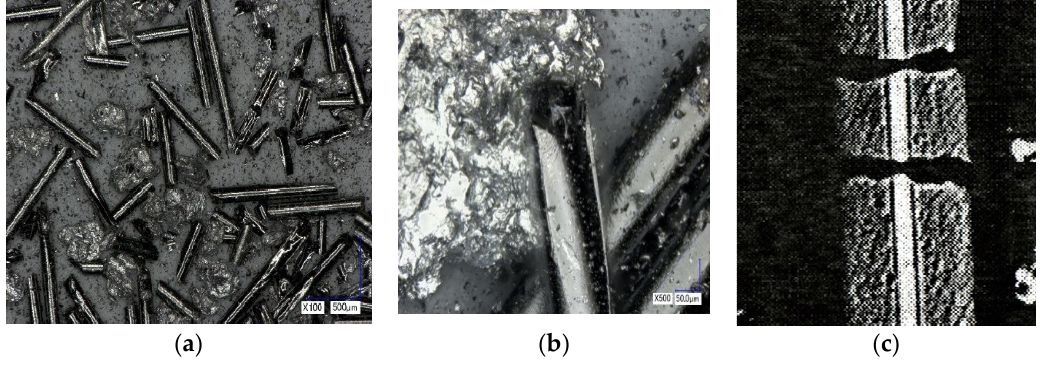
Figure 5. Microstructure of Al-W-B composite after grinding in a vibrating mill ( a – c ). The grinding in the disintegrator makes it possible to obtain a fraction of the powder component in a given range (Figure 6).